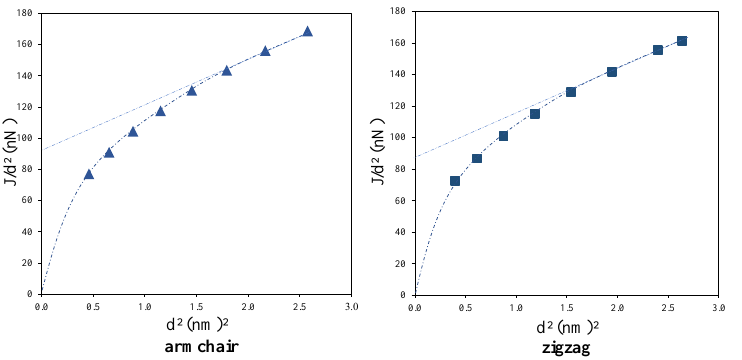
Figure 8. Plot of torsional rigidity divided by the square of the diameter vs. the square of the external diameter for armchair and zigzag